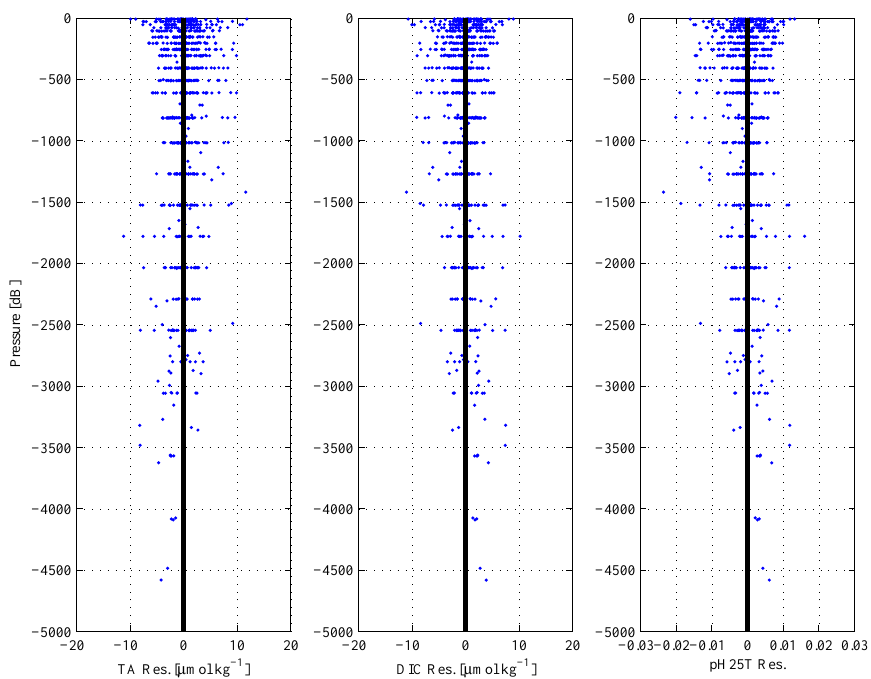
− 1 ) , DIC (µmolkg − 1 ) and pH25T using